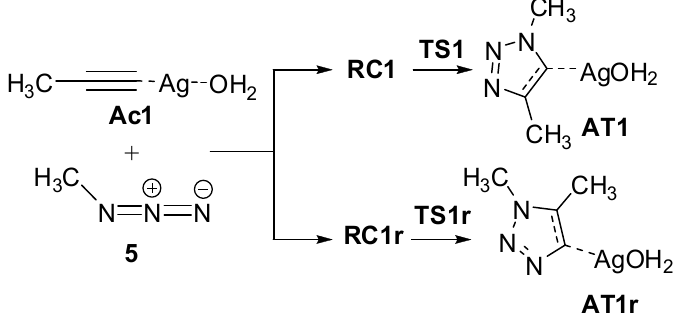
Figure 6. AgAAC reaction of Ac1 with 5 .